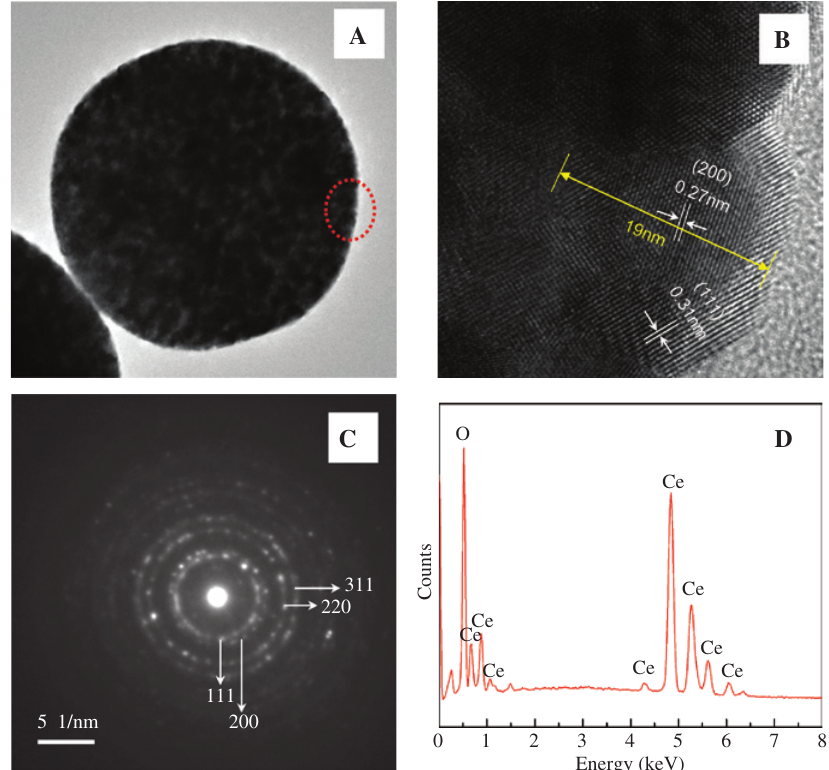
microspheres prepared at 700 ° C in air atmosphere. 2